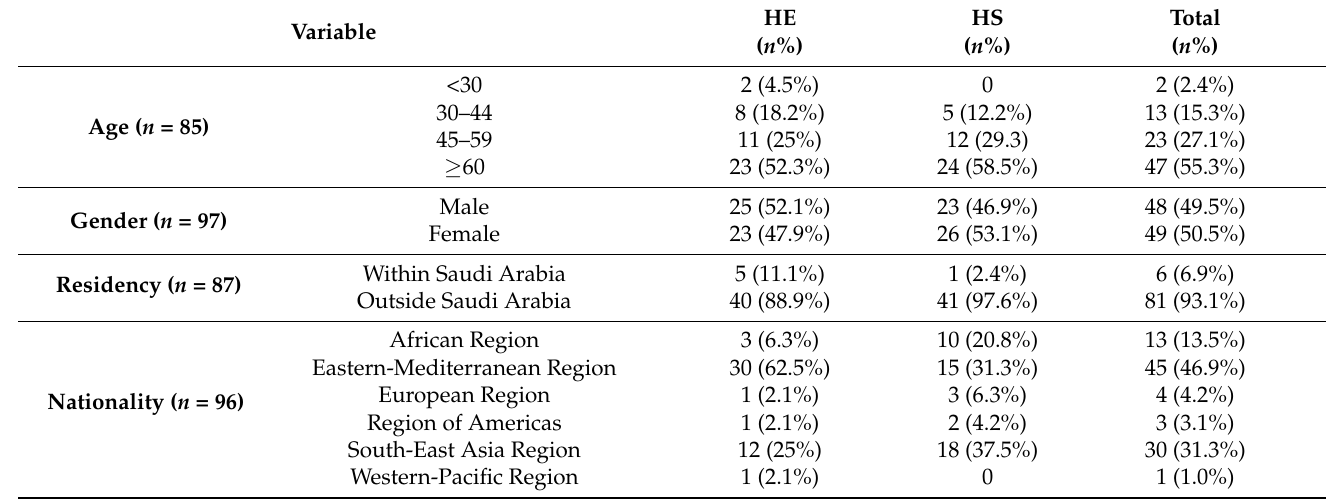
Table 1. Demographic characteristics of the enrolled population diagnosed with heat stroke (HS) and heat exhaustion (HE) in the 2019 Hajj ( n =